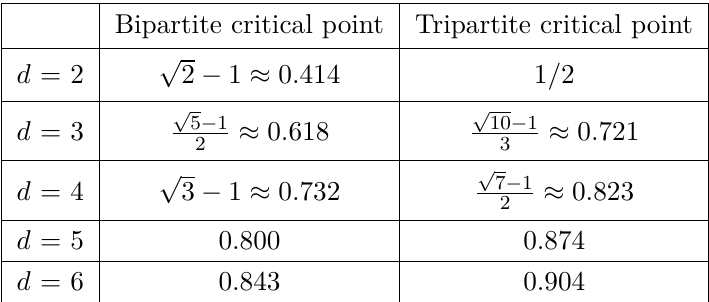
Table 1 . Bipartite and tripartite critical points for a symmetric configuration for various d in case of pure AdS. Note the amusing connection to metallic numbers [63]. See appendix C for the derivation of the